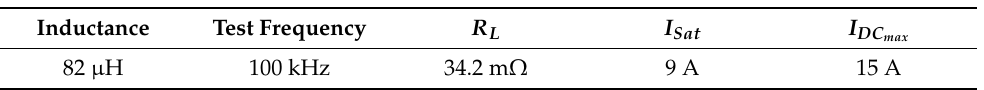
Figure 22. Convergence plots of the ( a ) global error and its breakdown into its ( b ) voltage and current errors. Table 3. Inductor’s main parameters summarized from the datasheet presented by Pulse Electronics ® in [40].